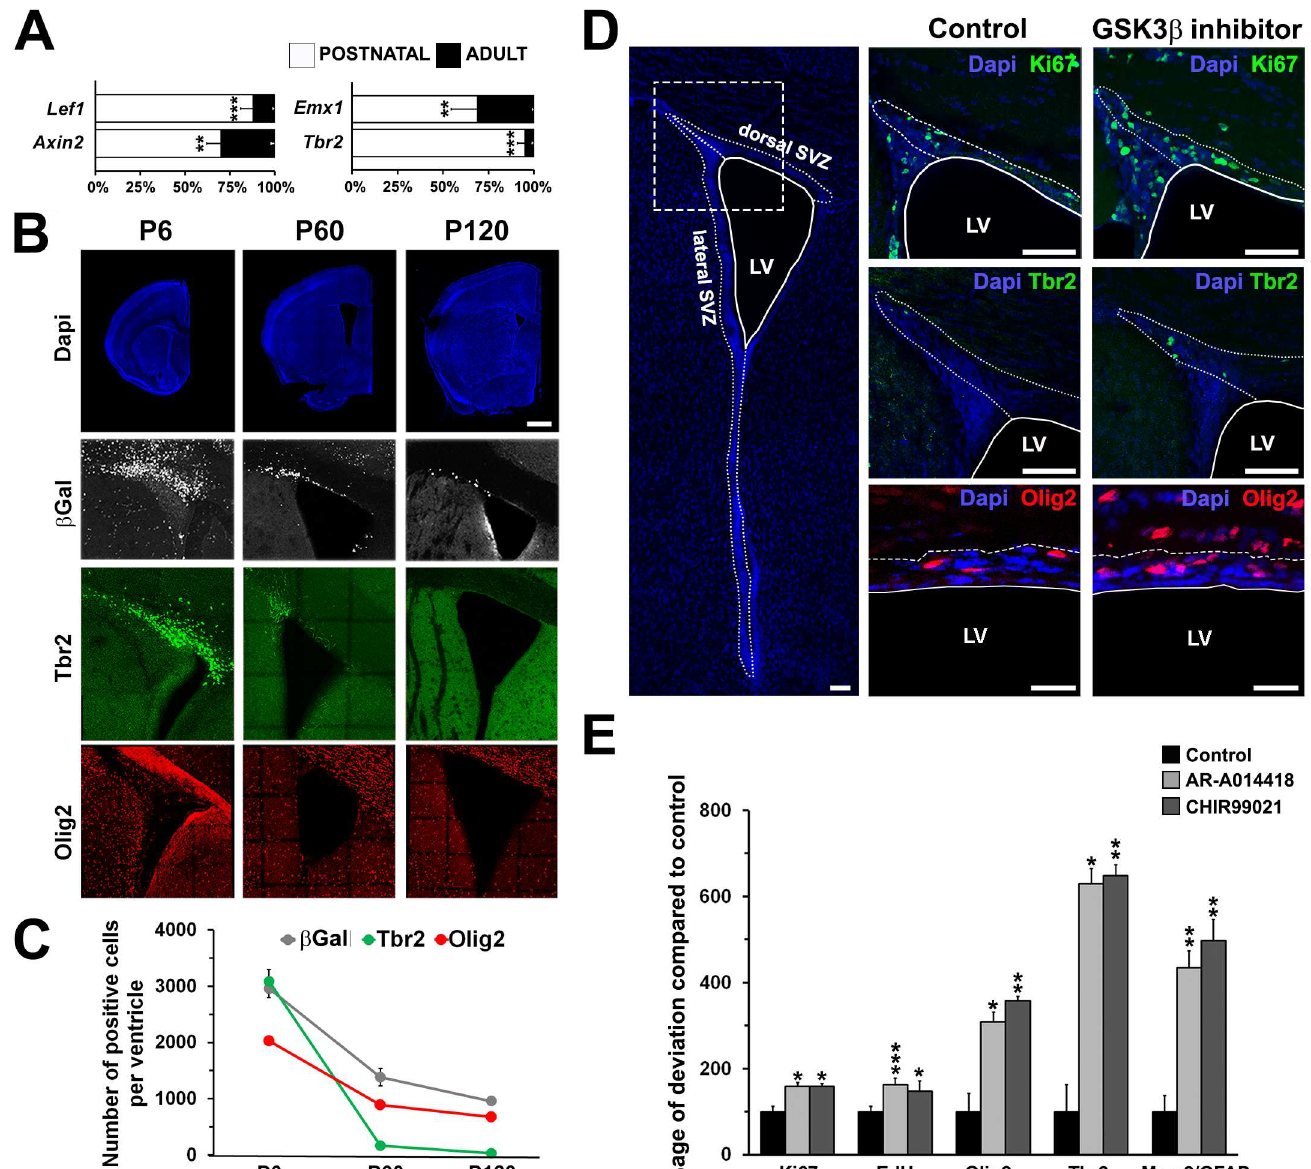
Fig 6. Pharmacological stimulation of Wnt/ β -catenin signaling rescuesoligodendrocyte precursor (OP) and glutamatergic neuron progenitor numbers in the adult mouse. (A) QuantitativePCR (qPCR) analysisreveals a pronounced decreaseof Wnt targets genes Lef1 and Axin2 and pallial Emx1 and Tbr2 transcripts expression in the dorsalsubventricular zone(dSVZ) betweenP6 and P60 ( n = 3 for P6 and P60). Results are expressed as a percentage andnormalizedin comparison with Gapdh level of expression andcomparedusingunpaired t test. (B) Representative coronalsections illustratingthe pronounced andrapid decreaseof Wnt canonicalsignalingin the β Galreporter mouse( β GAL+)and the paralleldecreaseof glutamatergic NPs (Tbr2+) and OPs (Olig2+) in the SVZ of mouse brain at the age of 6 d (P6), 2 mo (P60), and4 mo (P120) ( n = 3 individual animalsfor eachtime point). (C) Quantification of the averagenumber of β GAL+, Tbr2+, and Olig2+cells in the dorsal wall of the SVZ in P6, P60, and P120 mice (3 animalsper age). (D) Representative pictures of Ki67, Tbr2, and Olig2 expression in the adult (P90) SVZ beforeand after treatment with GSK3 β inhibitors (AR-A014418, not shown,and CHIR99021, shown). (E) Percentage increaseof proliferation (Ki67, EdU), OPs (Olig2),glutamatergic NPs (Tbr2), and NSC (Mcm2/ GFAP) numbersfollowingintraventricular infusionof AR-A014418 (3–10 μ M) and CHIR99021 (3–10 μ M). Valuesare normalizedcomparedto the controls ( n = 5 for each of control, AR-A014418, and CHIR99021). Error bars representstandarderror of the mean (SEM). ***, p < 0.001; ** ,p < 0.01; * , p < 0.05; t test. Scale Bar = 1 mm (B) and 50 μ m (D) .